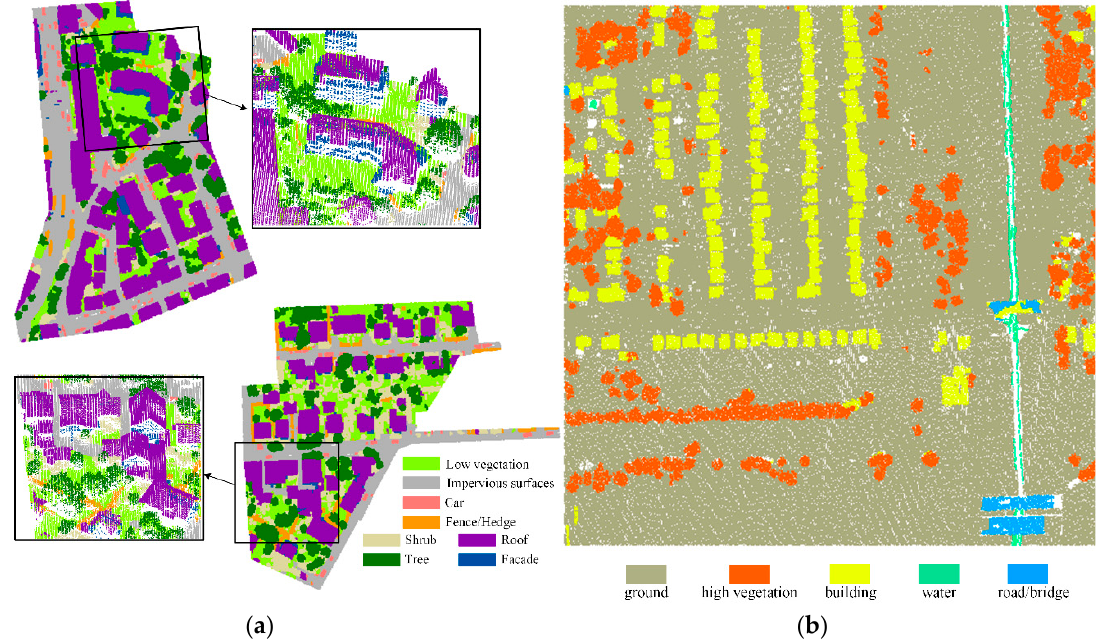
Figure 9. The experimental result: ( a ) the classification results of ISPRS benchmark dataset (the black boxes in the figure represent partial enlargements to show details of the classification result), ( b ) the classification results of the 2019 IEEE GRSS Data Fusion Competition dataset.